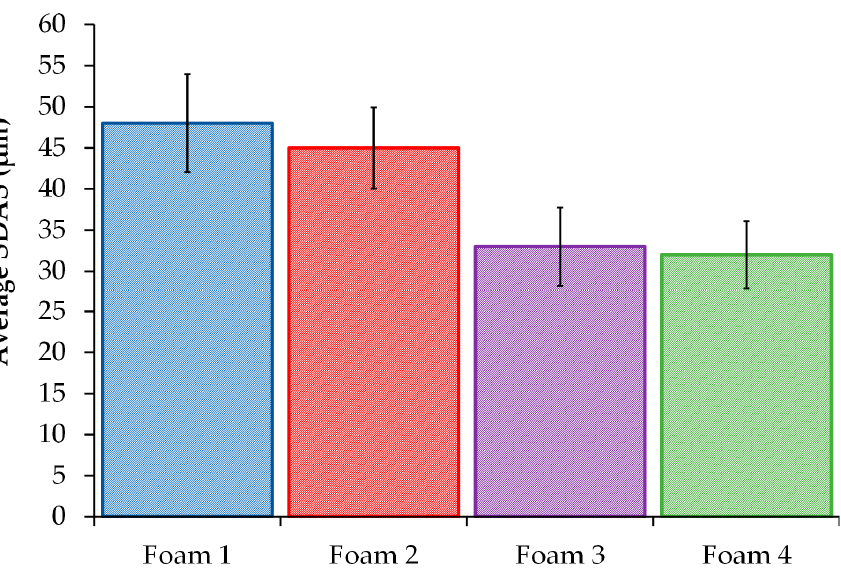
Figure 11. Variation of the average SDAS determination for the foams